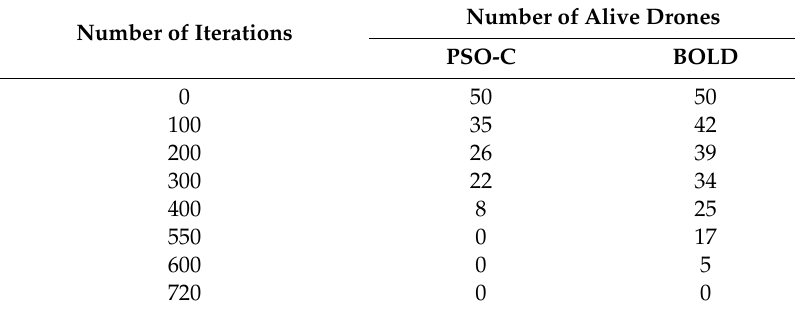
Figure 15. Network lifetime vs number of drones. Table 6. Number of alive drones vs number of iterations.